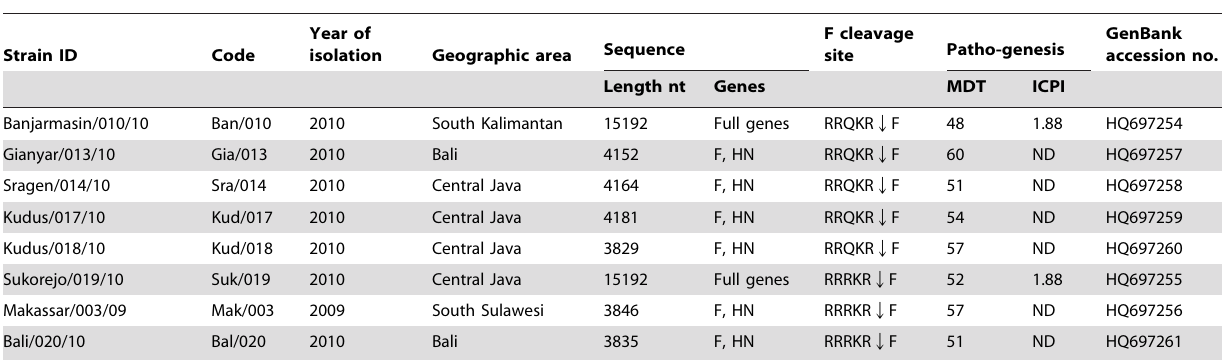
Table 1. Database of NDV Indonesia isolates in this study.